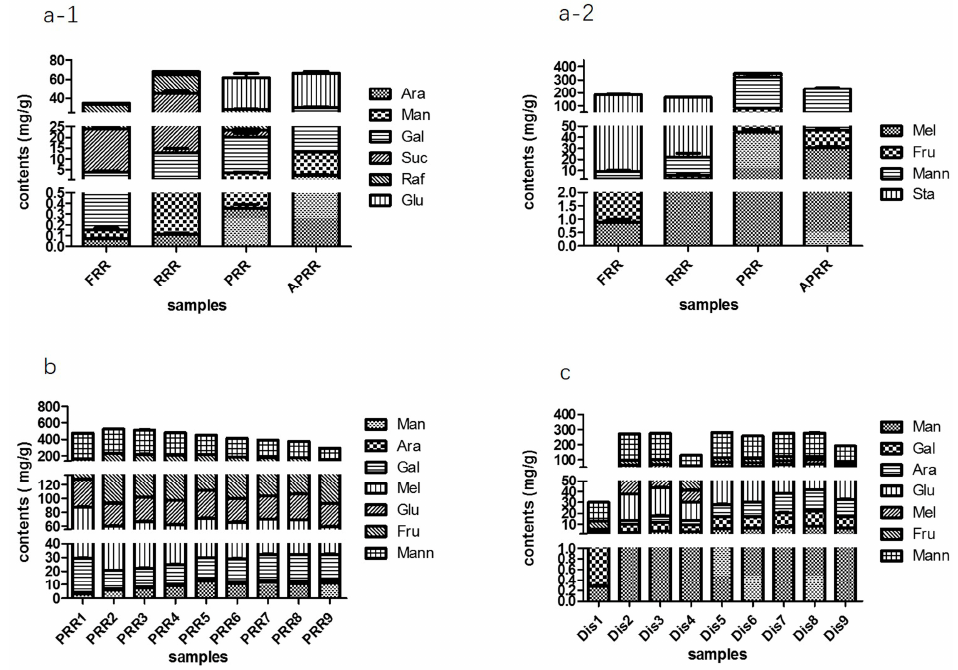
Figure 3. Contents of oligosaccharides and monosaccharides in FRR and ( a-1 , a-2 ) its three different processed RRs; ( b ) PRR1 to PRR9; and ( c ) Dis1 to Dis9.